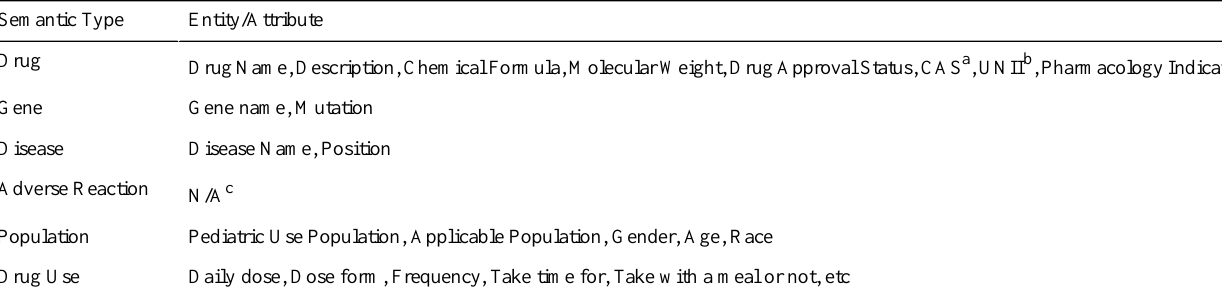
Table 1. Semantic types and attributes in the knowledge model.